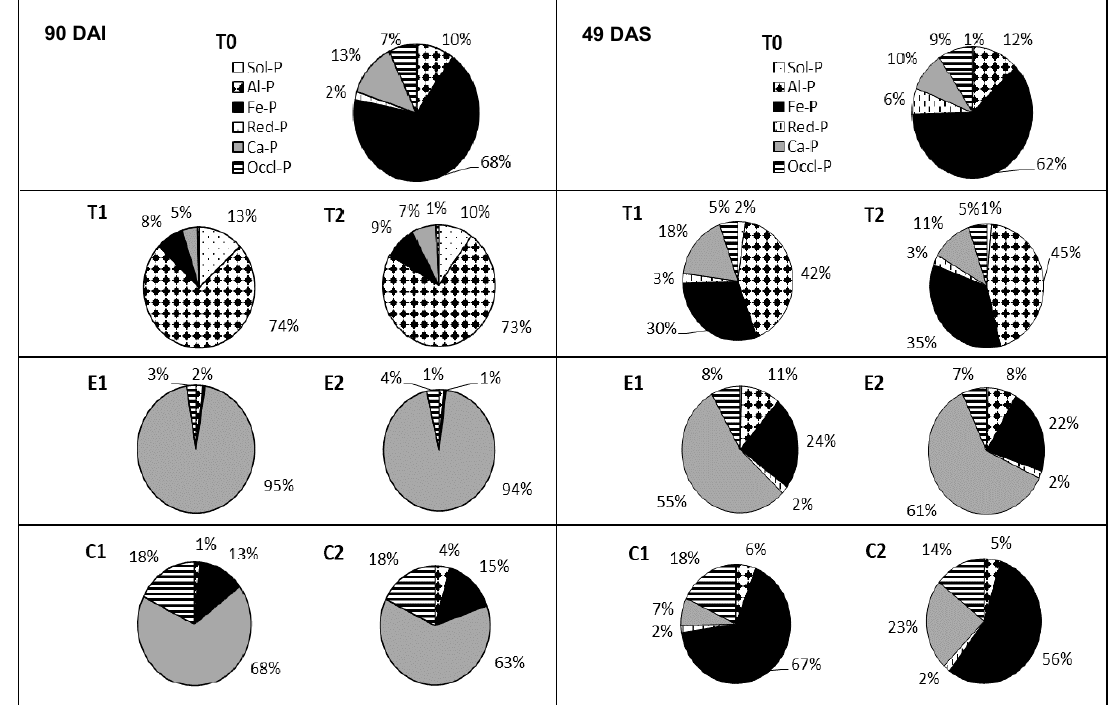
Figure 2. Percentages of inorganic P speciation at 90 days after incubation and 49 days after seeding. Sol-P is loosely soluble P, Al–P is aluminum bound P, Fe–P is iron bound P, Ca–P is calcium bound P, Red-P is reductant P, and Occl-P is occluded P. T0—Soil alone, T1—triple superphosphate (TSP) at 100%, T2—TSP 75% + Clinoptilolite zeolite (CZ), C1—Christmas Island Rock phosphate (CIRP) at 100%, C2—CIRP 75% + CZ, E1—Egypt Rock phosphate (ERP) at 100%, E2—ERP 75% + CZ.